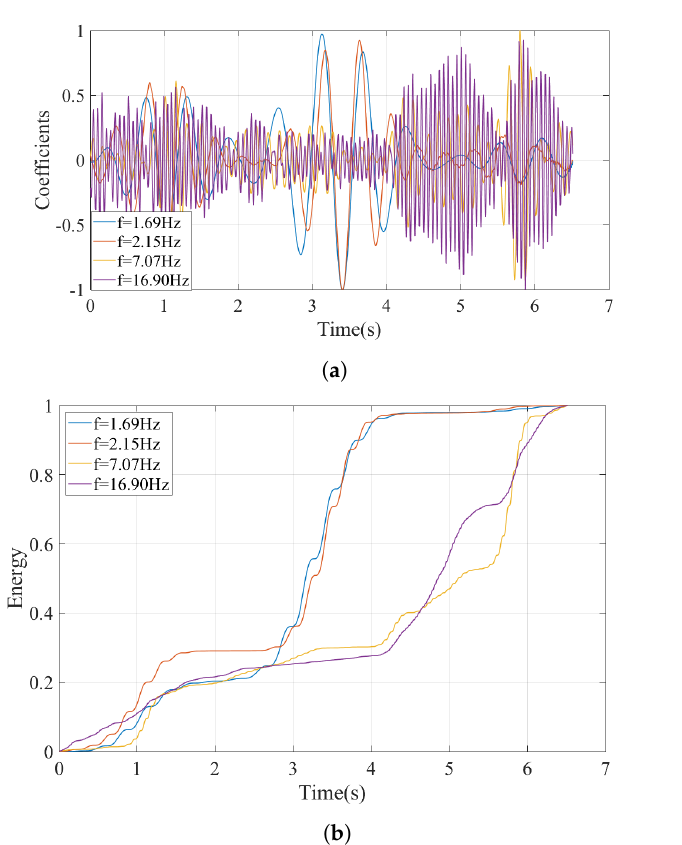
Figure 19. ( a ) Coefficients time history and ( b ) energy at different frequencies computed using CWT for V = 90